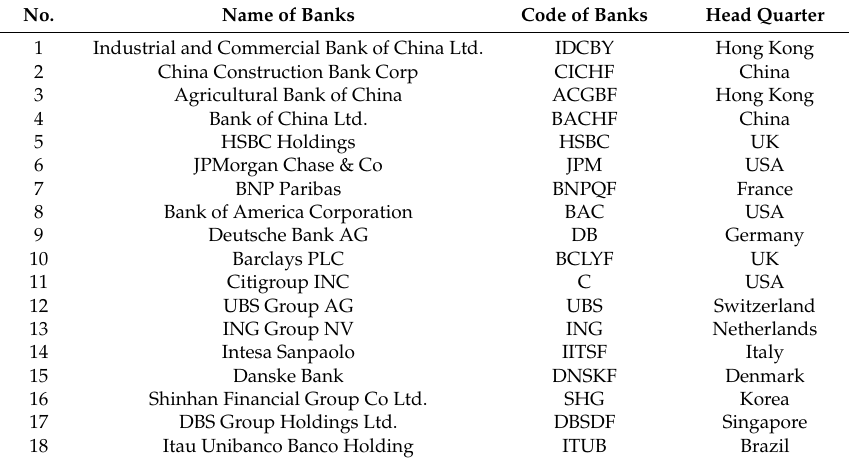
Table 1. List of 18 large banks all over the